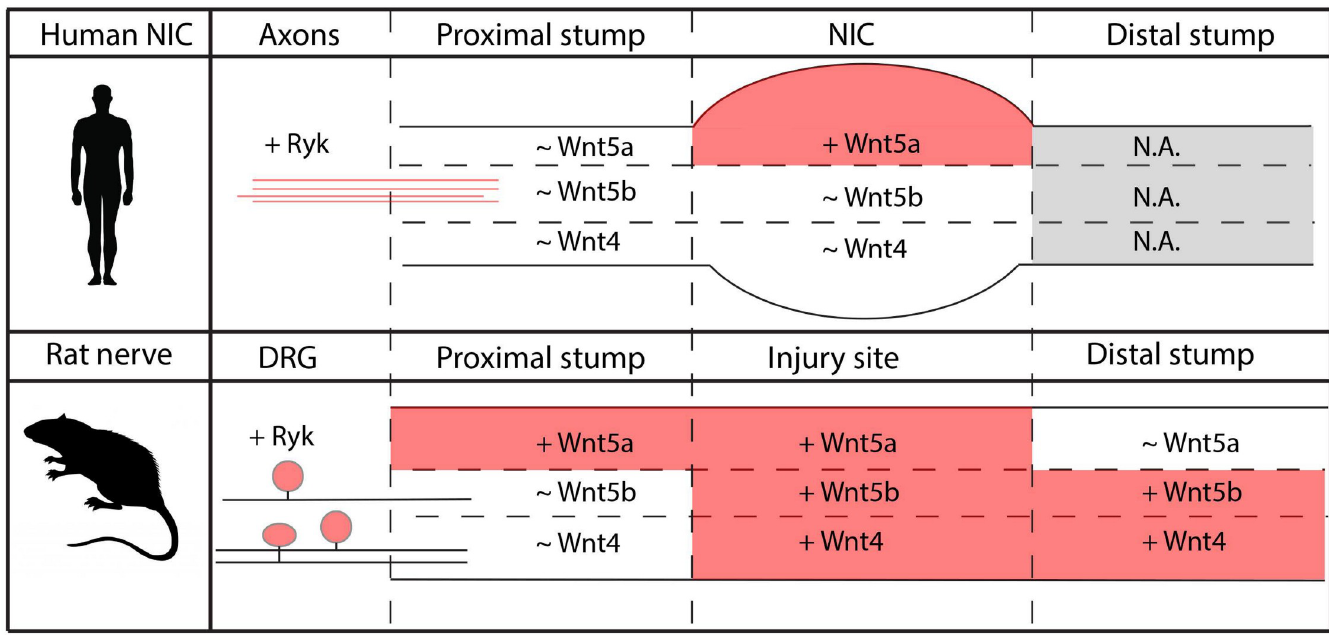
Fig 10. Comparative summary of Wnt5a, 5b and Wnt4 expression in human NIC and the injured rat nerve. Summary of the observations on Wnt5a, Wnt5b and Wnt4 expression in human NIC and in the injured rat sciatic nerve. In NIC tissue Wnt5a mRNA levels are increased (indicated by + and red colour) compared to the proximal stump while Wnt5b and Wnt4 mRNA expression are detectable in the proximal stump and NIC but the levels are not increased (indicate by ~ and no colour). Following injury of the rat nerve Wnt5a mRNA expression is induced in the proximal stump and at the injury site. Wnt5b and Wnt4 mRNA levels are increased at the injury site and the distal stump in comparison to the proximal stump. The Wnt5a receptor RYK is clearly detectable on axons in the NIC and is induced in rat DRG neurons following nerve injury. Human distal nerve stumps were not analysed (N.A.).